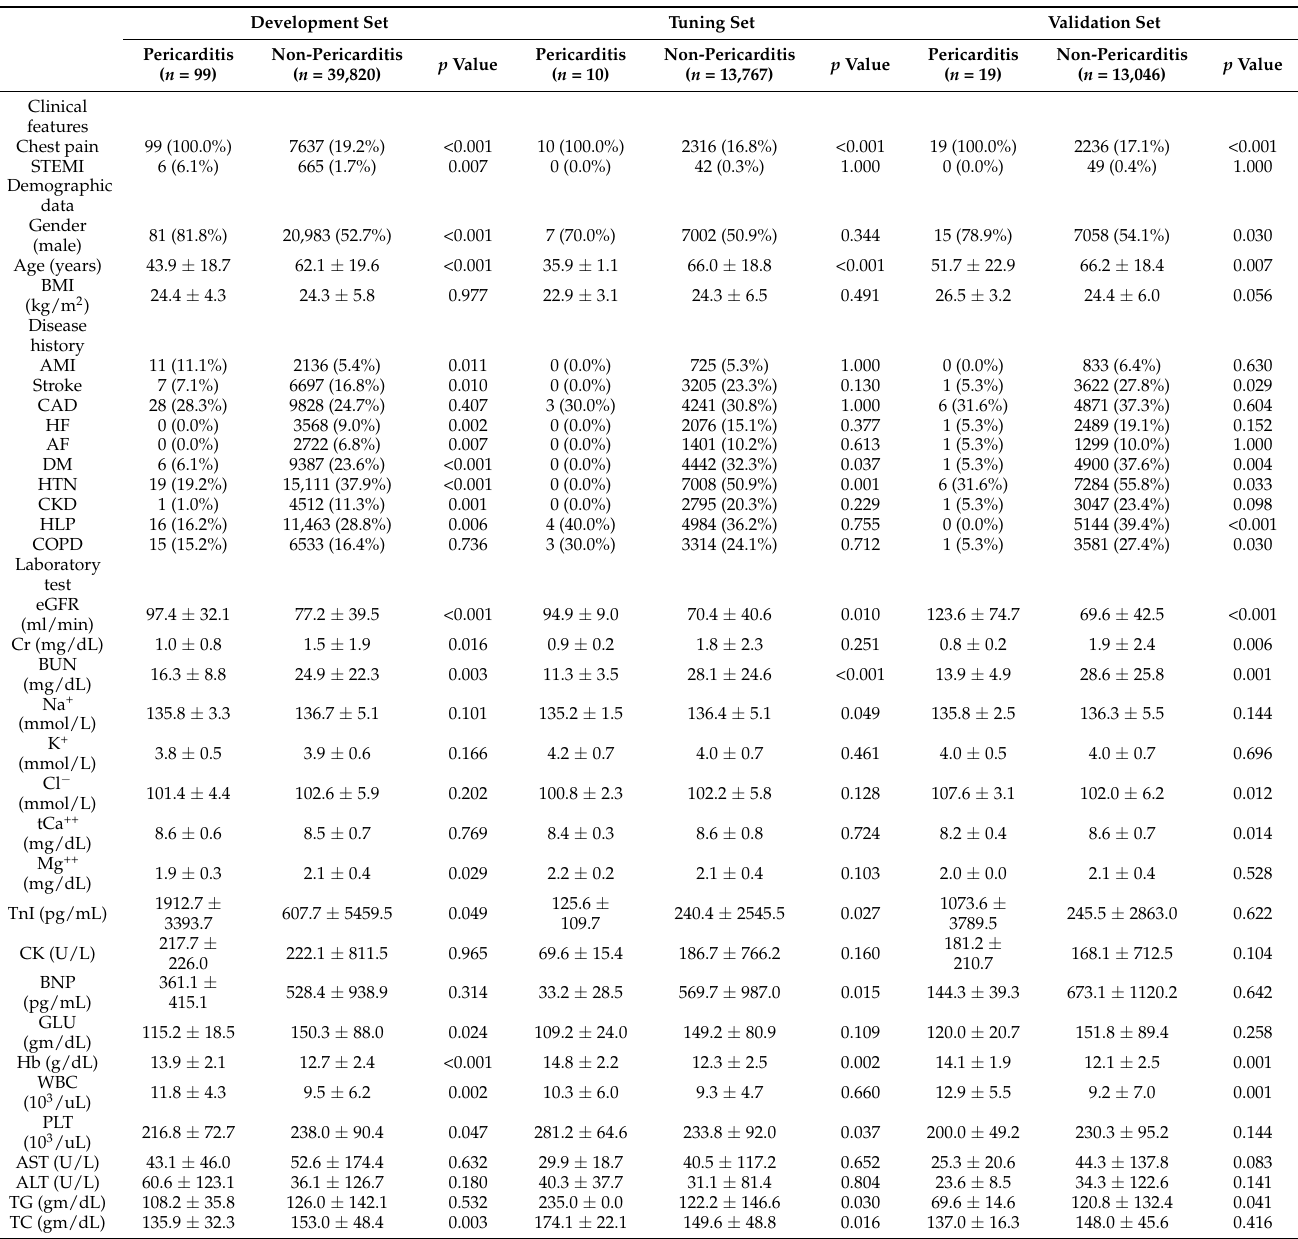
Table 1. Corresponding patient characteristics of pericarditis and non-pericarditis visits in each